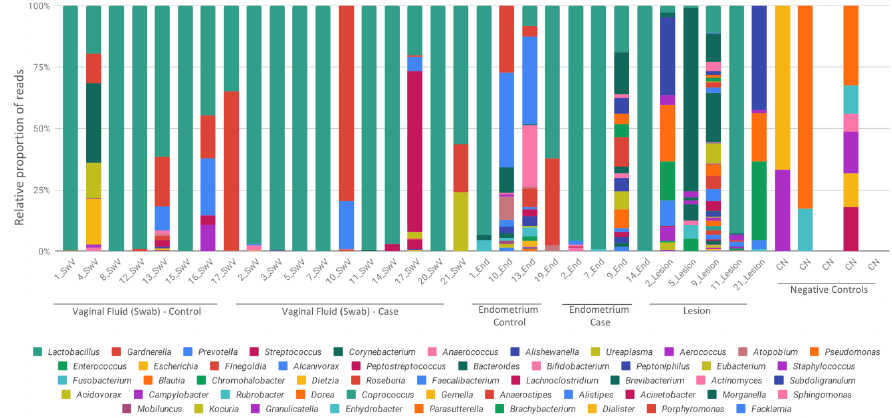
Figure 1. Relative abundance of bacterial profiles. Bacterial composition of each sample is reported by color bars relative to a 100% scale. Results are presented by the taxonomic rank of genus. SwV—vaginal fluid (Swab), End—endometrium, CN—negative controls.